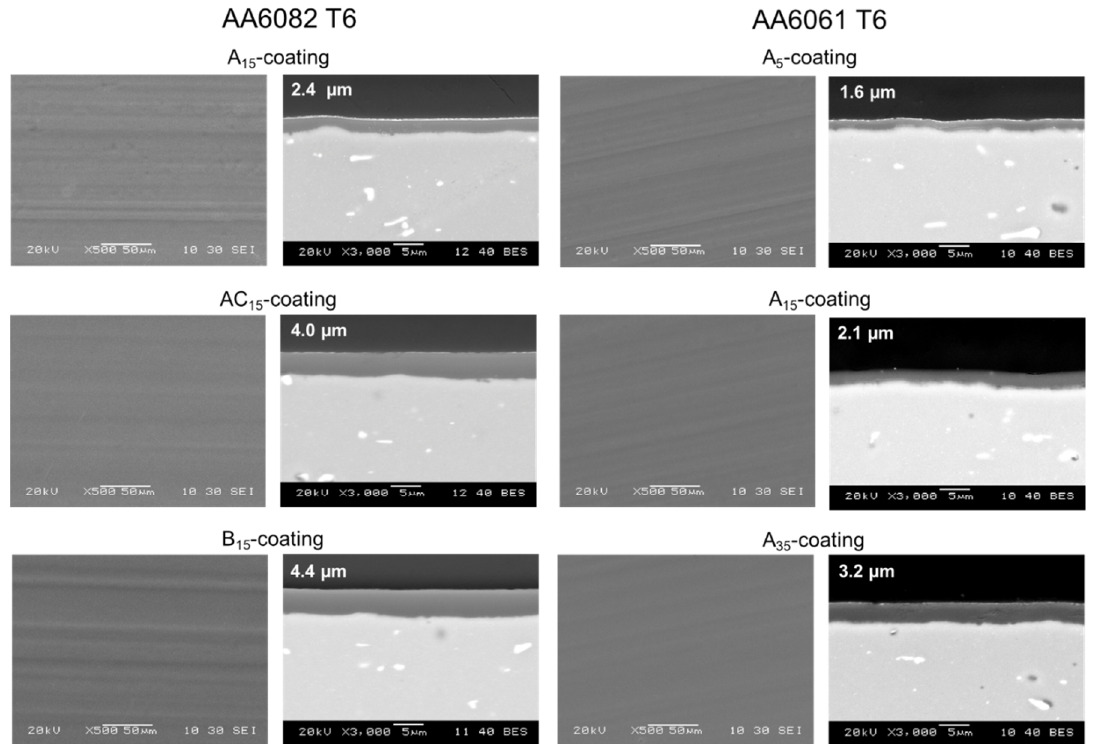
Figure 2. Top-view and cross-section SEM images of coated AA6082 T6 and AA6061 T6.